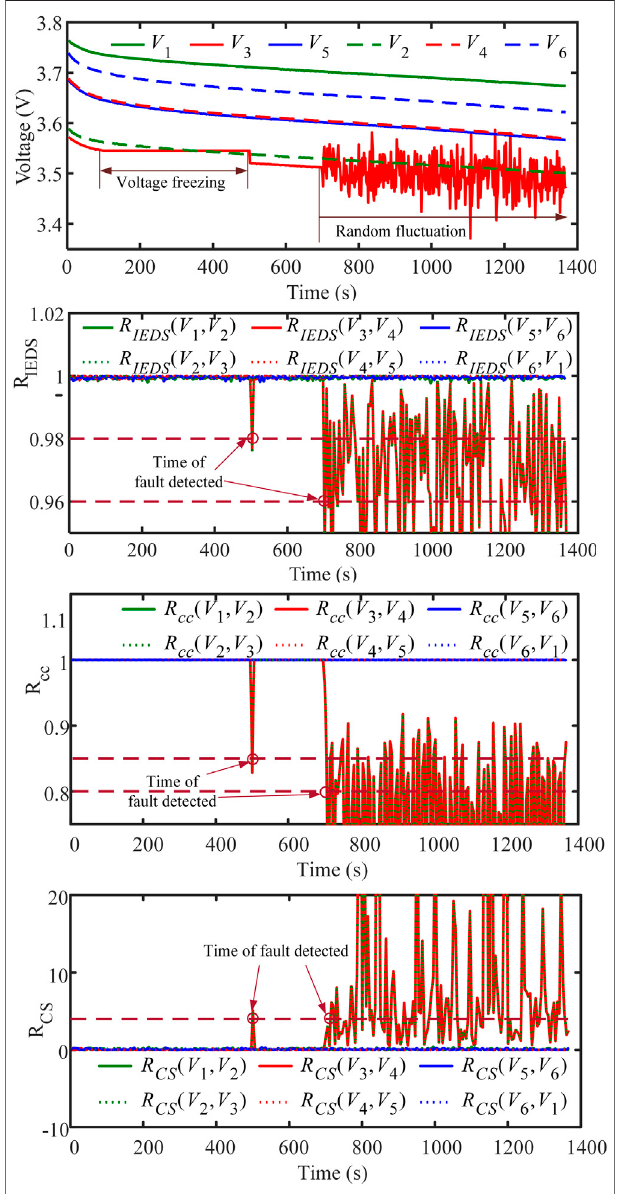
FIGURE 9 | Voltage sensor fault evaluation results. (a) Voltage curve. Diagnosis by (b) R IEDS , (c) R cc , (d) R CS .